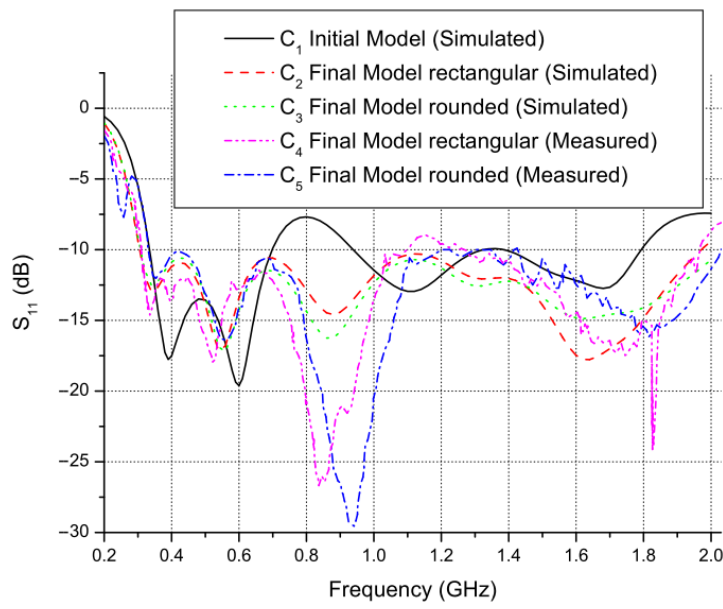
Figure A1. Simulated and measured reflection coefficients of the antennas.